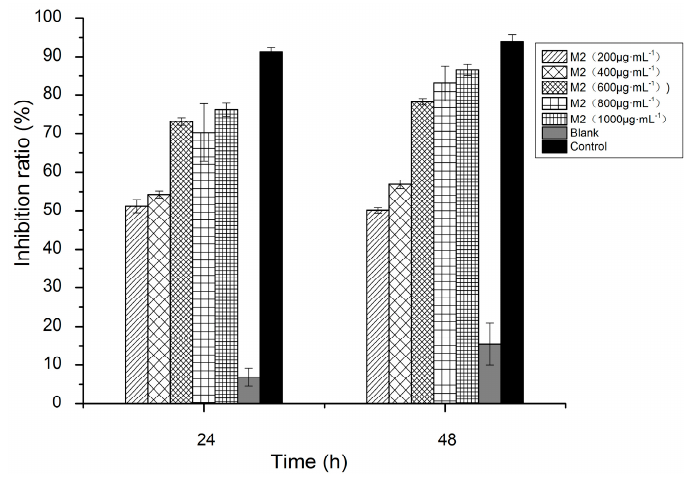
Figure 6. The antitumor activity of M2 on HT-29 cells after different incubation periods and at different concentrations in 3-(4,5-cimethylthiazol-2-yl)-2,5-diphenyl tetrazolium bromide (MTT) assay.